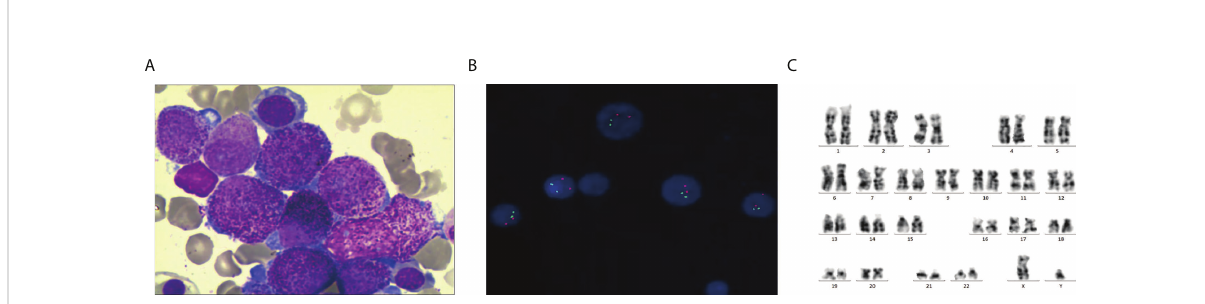
FIGURE 1 Morphology, FISH, and karyotyping analysis of the patient ’ s AML bone marrow (BM) sample. (A) Promyelocytes with hypergranulated cytoplasm and invaginated nuclei (Wright – Giemsa-stained BM smear, 1,000× magni fi cation). (B) PML – RARA fusion signals were not detected by Interphase FISH using PML – RARA dual-color, dual-fusion translocation probes. (C) G-banded karyotype showing 46, XY